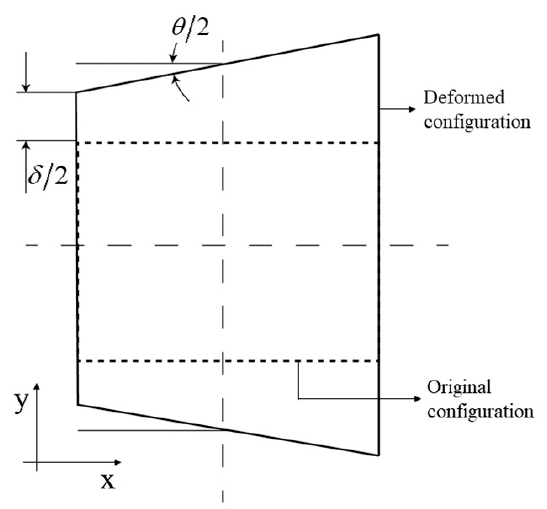
Figure 9. Schematic representation of the deformed and undeformed configuration for the welded plates.